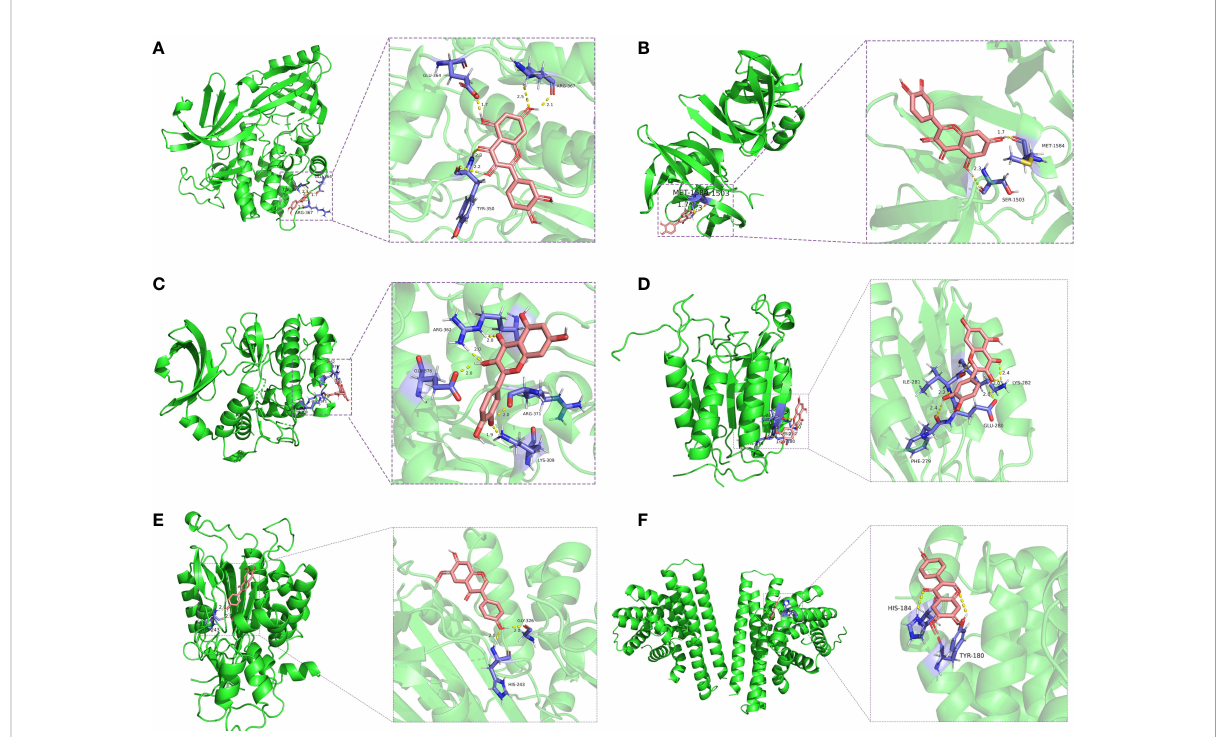
FIGURE 6 Three-dimensional schematic diagram of the molecular docking model, showing active sites and binding distances. (A – D) Binding mode of quercetin (GQZ33) to (A) AKT1, (B) TP53, (C) MYC, and (D) Caspase8. (E, F) Binding mode of glycitein (GQZ12) to (E) Caspase9 and (F)